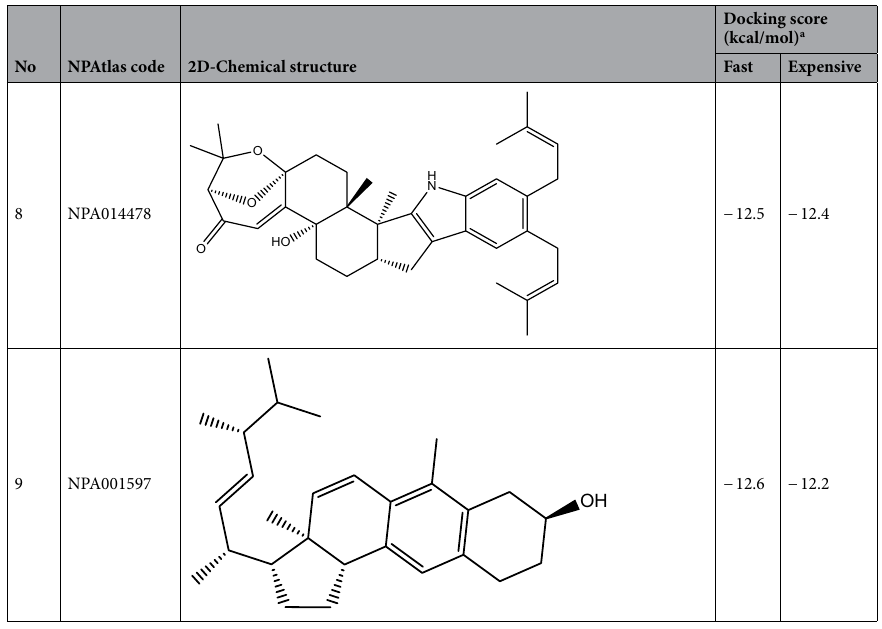
Table 2. 2D chemical structures and evaluated docking scores (in kcal/mol) for SirReal2 and nine promising NPAtlas compounds towards SIRT2 protein. a Data ranked in accordance with the expensive docking